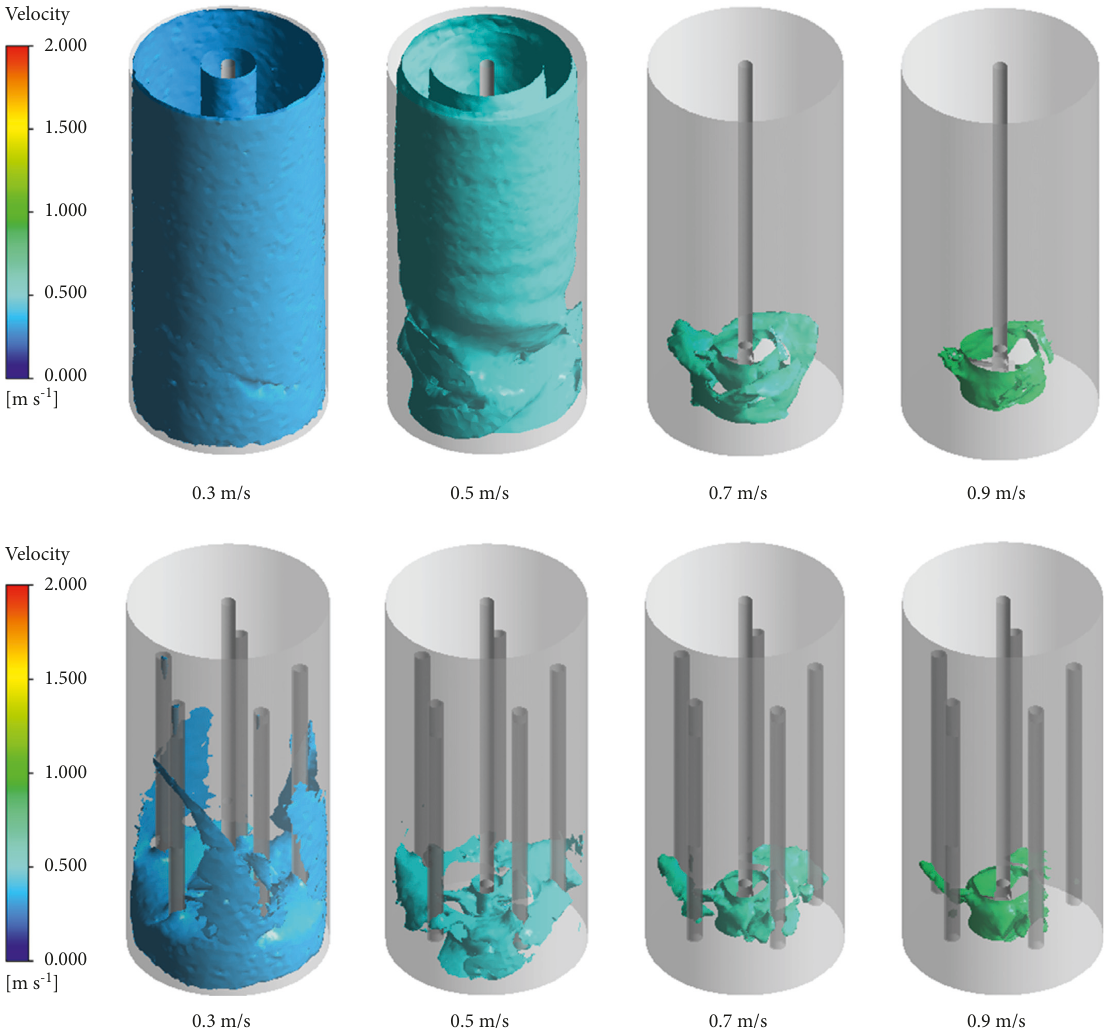
Figure 12: Cloud diagrams of the velocity iso-surface distribution in the